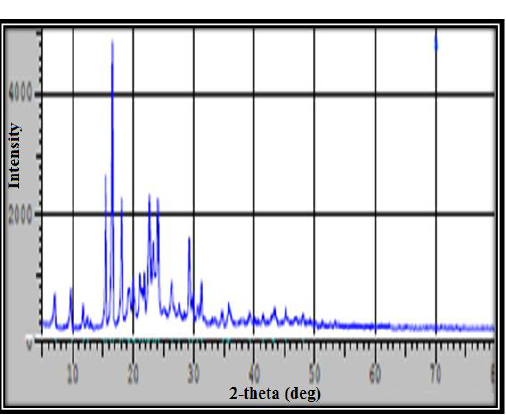
Figure 13.The DSC thermogram of the SD15